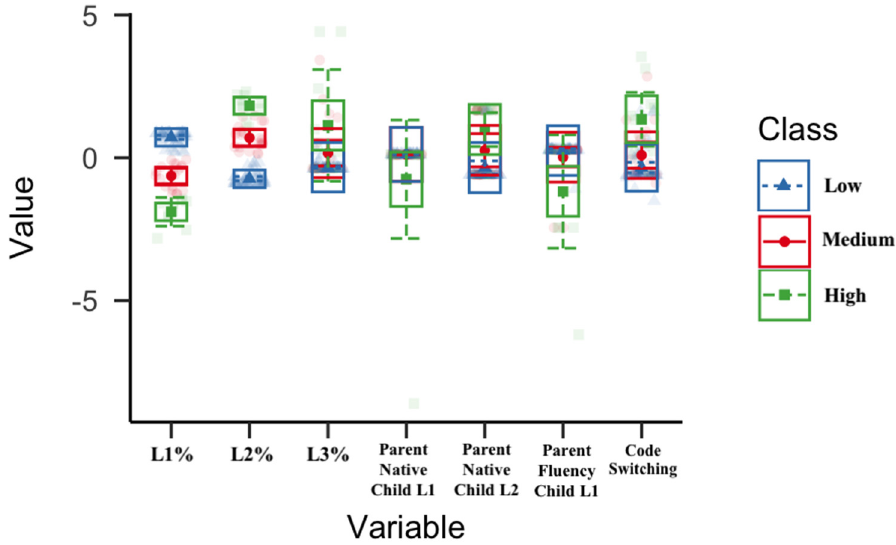
Figure 2. Latent Profile Plot for Analysis Approach 1. Variables were scaled for visualization purposes.